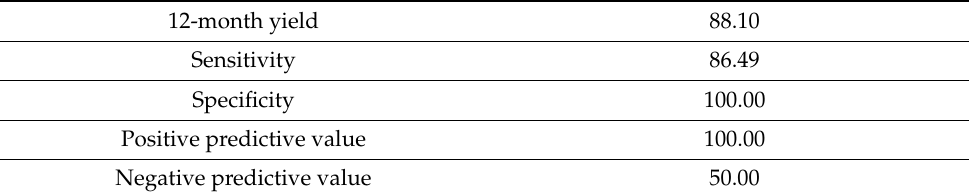
Table 2. Twelve-month outcomes.